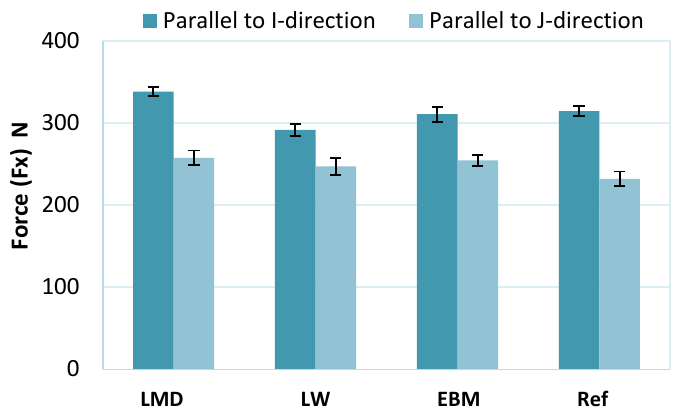
Figure 8. Forces along X-direction (feed) for the LMD, LW, EBM, and reference (Ref) materials.